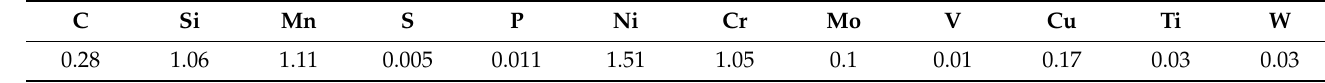
Table 1. Chemical composition of 30CrMnSiNi2A